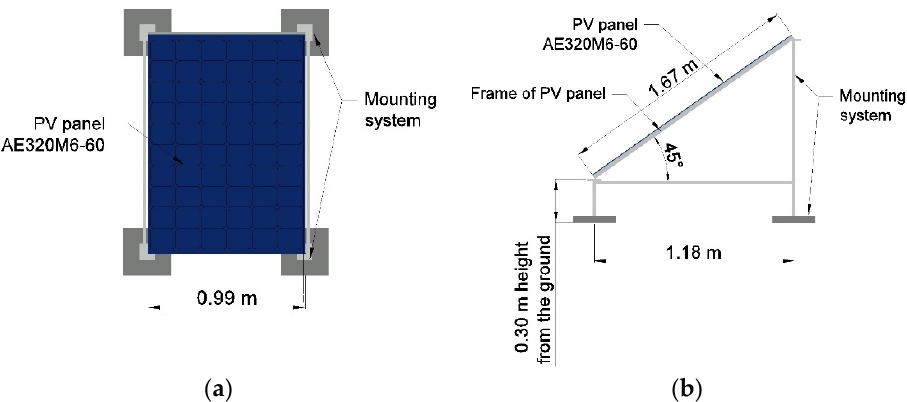
Figure 4. Position of the PV panel (fixed, tilted at 45°): ( a ) top view; ( b ) side view.